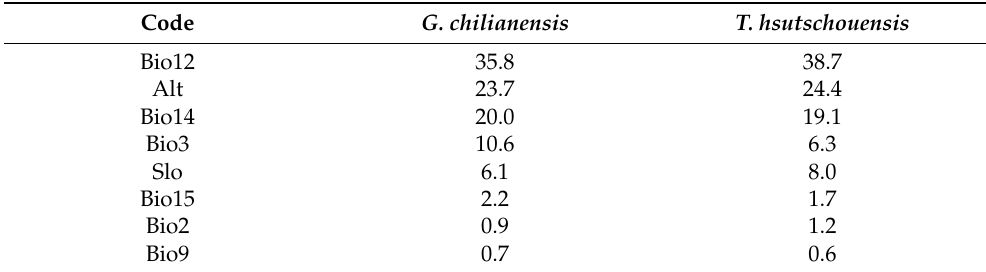
Table 3. Percent contribution (%) of the selected variables in the G. chilianensis and T. hsutschouensis model construction. Variable codes are shown in Table